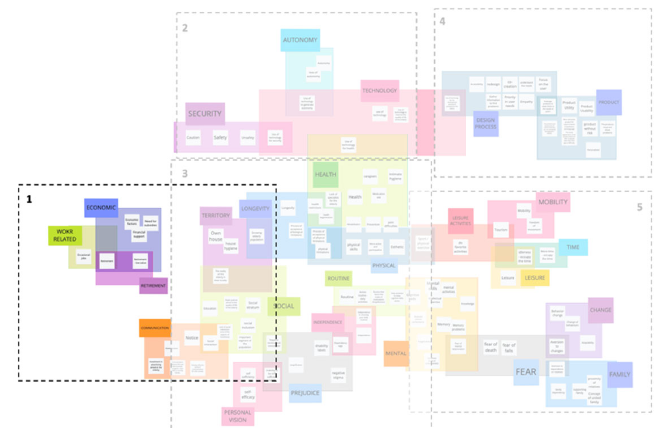
Figure A1. Map Section 1.